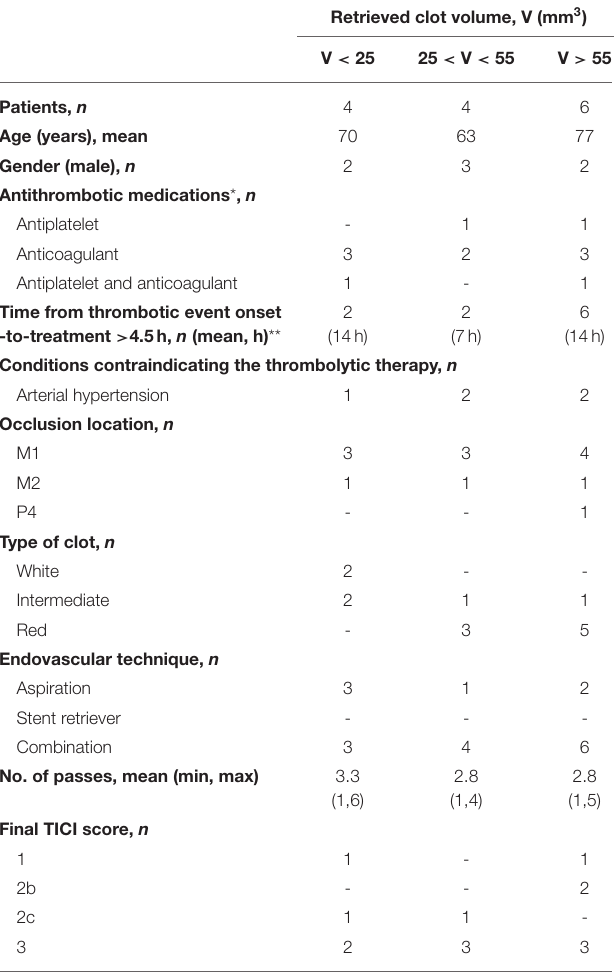
TABLE 1 | Baseline characteristics of patients with acute ischemic stroke included in this pilot